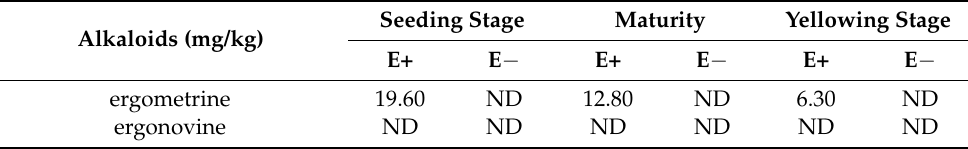
Table 1. Alkaloid content in aqueous extract of A. inebrians at different growth periods. Alkaloids